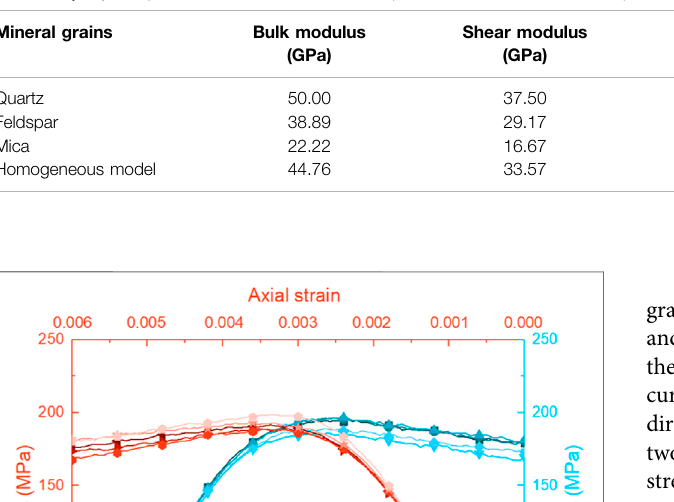
Table 1 . The physical parameters of the homogeneous model are weighted according to the proportion of mineral grains. The boundary condition is that the upper and lower boundaries are velocity loads, which are 1.9 × 10 – 9 m/step, and the other boundaries are free.